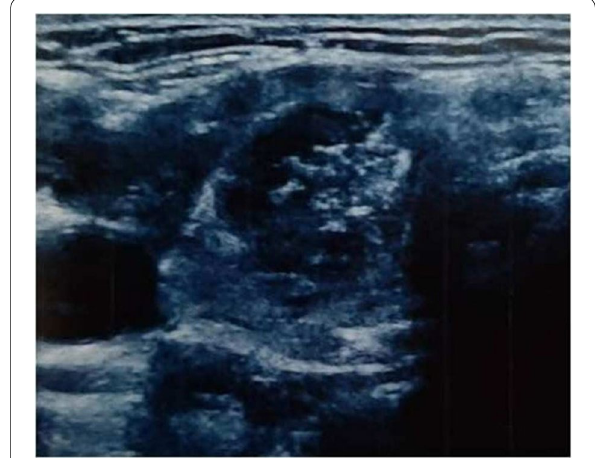
Fig. 1 Cervical ultrasound examination revealing an ill-defined hypo-echogenic mass of the thyroid gland right lobe, measuring 1.5 cm in diameter, with diffused micro-calcifications